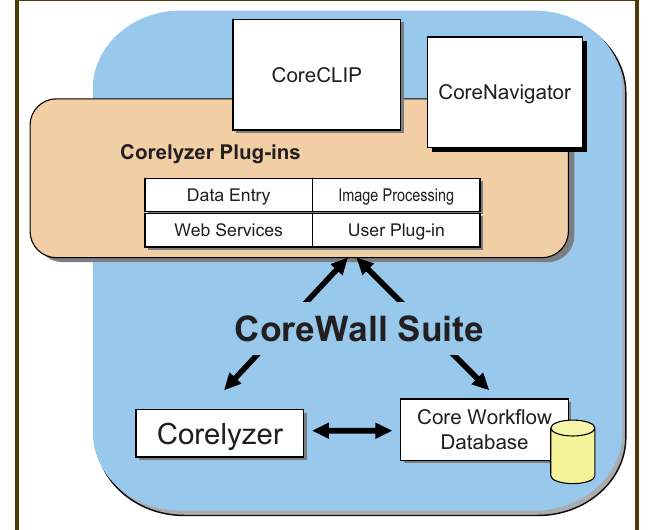
Figure 1. Components of CoreWall